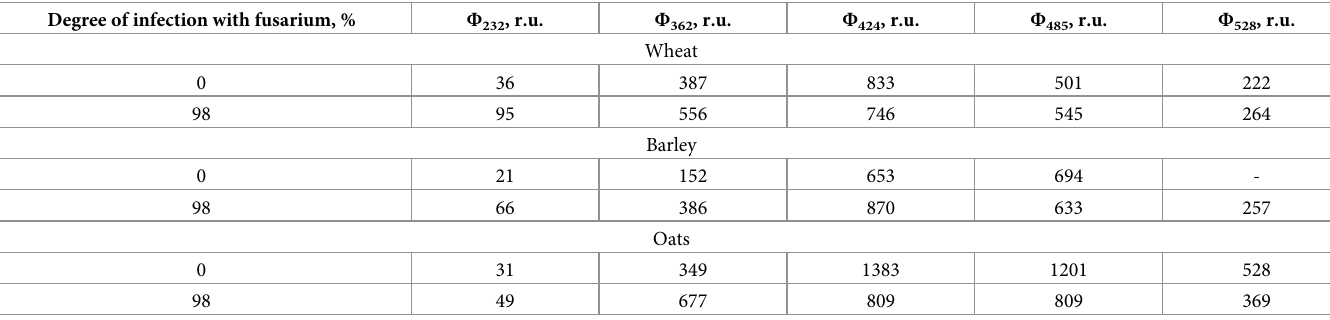
Table 2. Integral parameters of luminescence spectra of plant seeds of various degrees of fusarium infection. Degree of infection with fusarium, % Ф 232 , r.u. Ф 362 , r.u. Ф 424 , r.u. Ф 485 , r.u. Ф 528 , r.u.